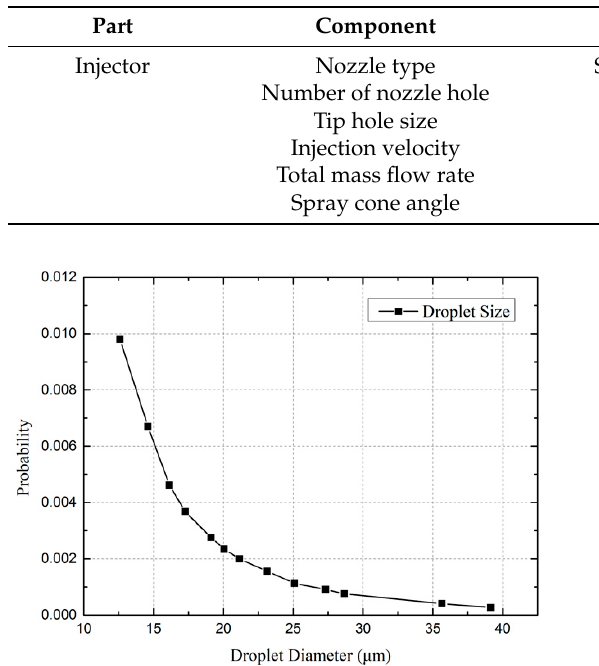
Table 2. Details of the injector.